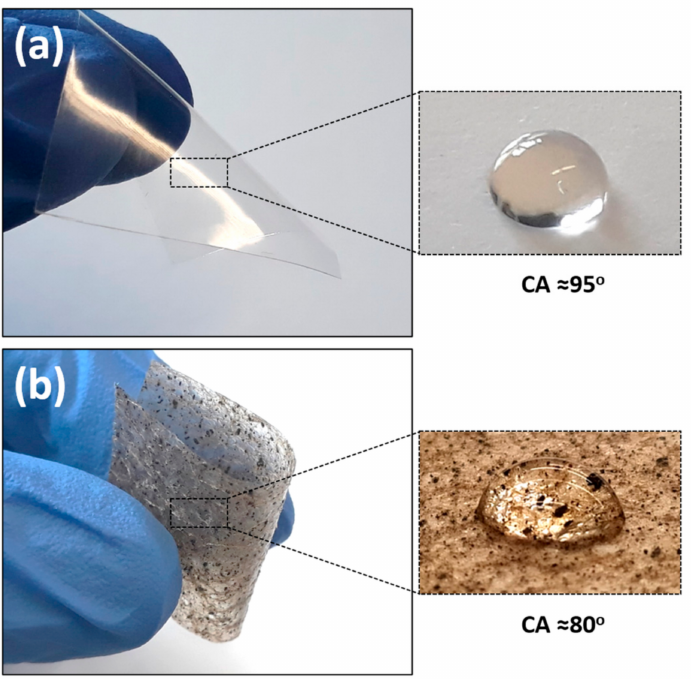
Figure 2. ( a ) Neat PLA ( b ) SVP-PLA composite patch and corresponding water contact angle (WCA) results.